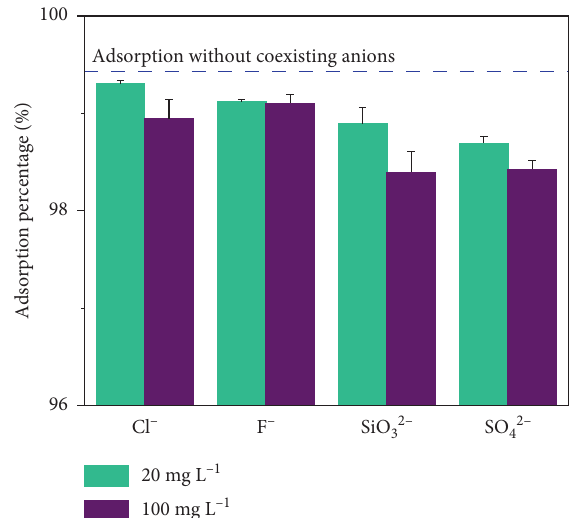
Figure 10: The effect of coexisting anions on phosphorus ad- sorption (pH � 7, t � 10min, adsorbent dosage � 2g · L − 1 , 120rpm, initial phosphorus concentration � 10mg · L − 1 , and 25 ° C).